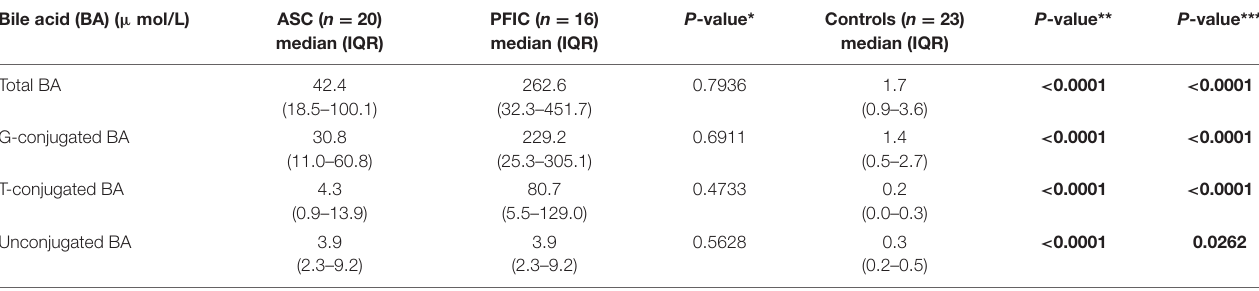
TABLE 3 | Total bile acid levels in pediatric ASC- and PFIC patients with and without pruritus and controls. Bile acid (BA) ( µ